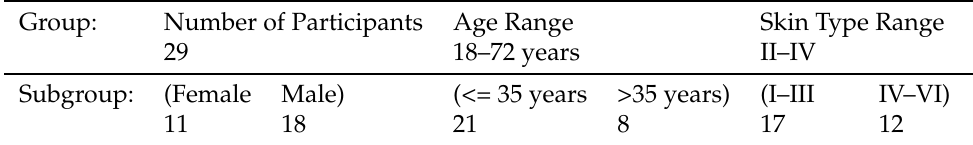
Table 3. Demographics of the participant